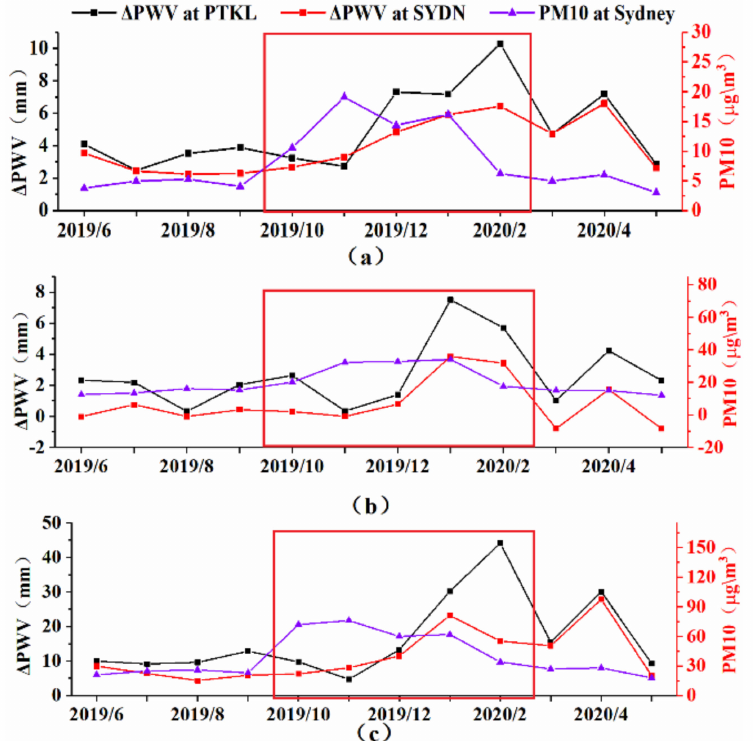
Figure 6. Statistical results of ∆ PWV and PM10 at PTKL and SYDN (( a ) STD statistics, ( b ) MEAN statistics, ( c ) MAX statistics of PTKL and